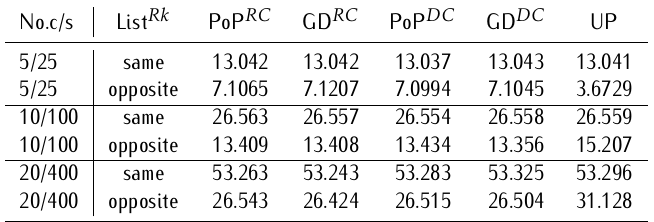
Table 4. Average Number of potential RDVs per cycle for the RAC 2 E-gQS; No.c/s stands for Number of channels / slots; List Rk is the channel ranking